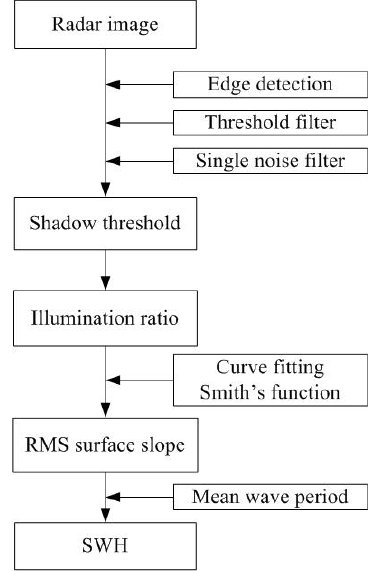
Figure 11. Basic steps of the shadowing-based algorithm